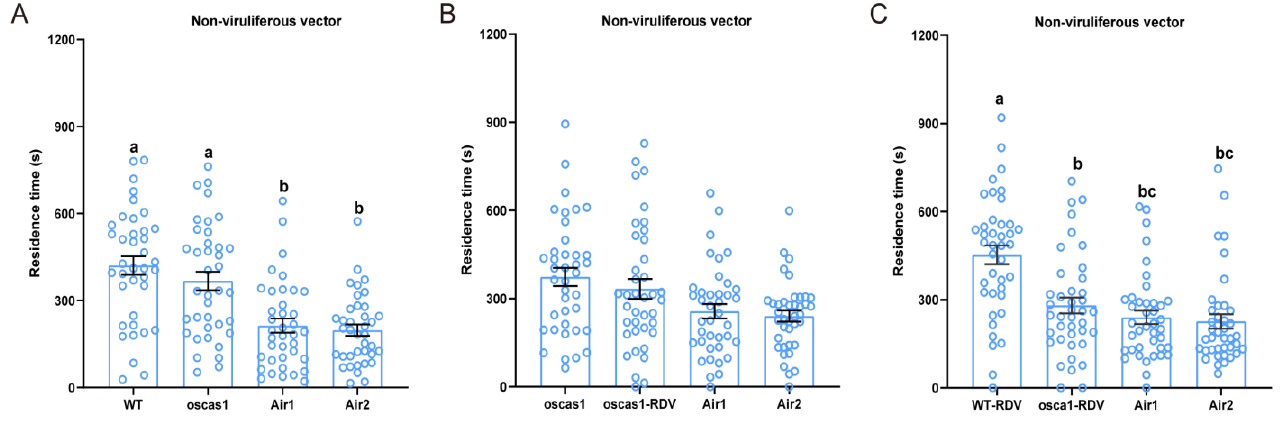
Figure 5 . Plant odor preferences of non-viruliferous N. virescens exposed to WT and oscas1 rice plants ( A ) ( n = 41); oscas1 and oscas1-RDV rice plants ( B ) ( n = 39); and WT-RDV and oscas1-RDV rice plants ( C ) ( n = 40). RDV, rice dwarf virus; WT, wild type (Minghui63, MH63) (RDV-free); WT- RDV, MH63-RDV (RDV-infected); oscas1, mutant rice plant (RDV-free); oscas1-RDV, mutant rice plant (RDV-infected). WT, WT plant odors; oscas1, oscas1 plant odors; oscas1-RDV, oscas1-RDV plant odors; WT-RDV, WT-RDV plant odors; Air1, clean air; Air2, clean air. Deviations from equal distribution were analyzed with a Friedman – ANOVA ( p < 0.05). Bars annotated with different letters are significantly different from each other (Wilcoxon–Wilcox test). Data are mean ± standard